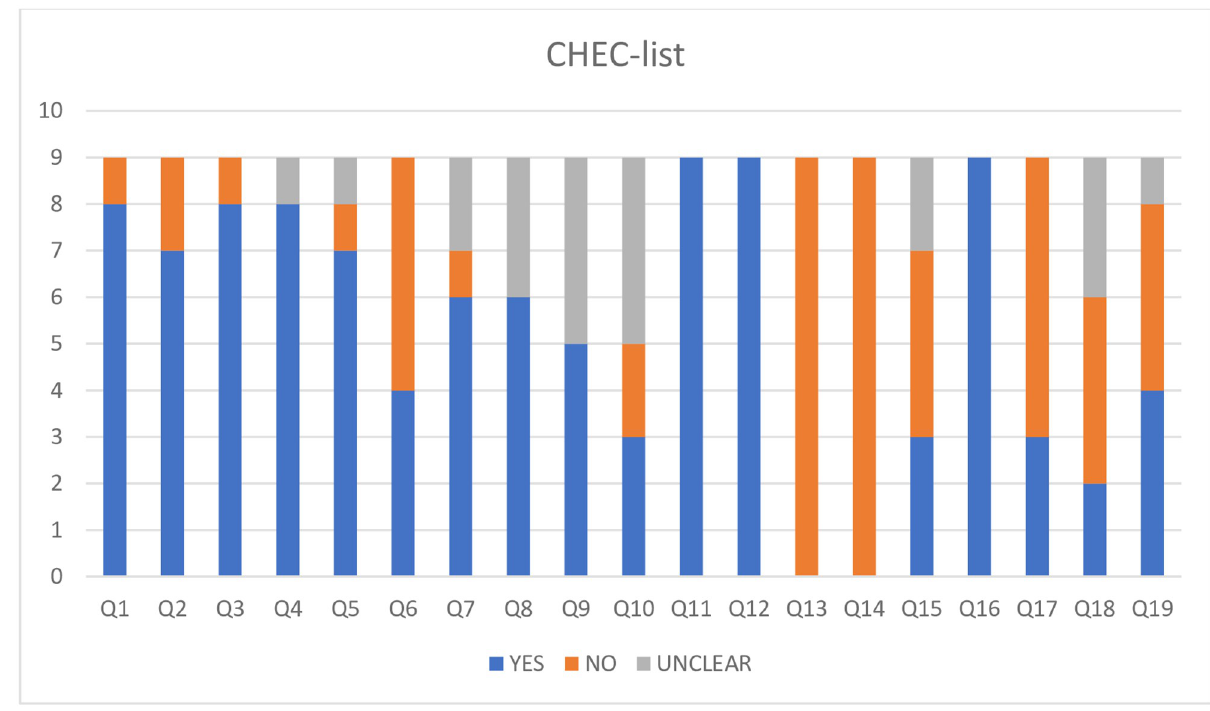
Fig 2. CHEClist (Evers et al.; 2005) [see S2 Table for more